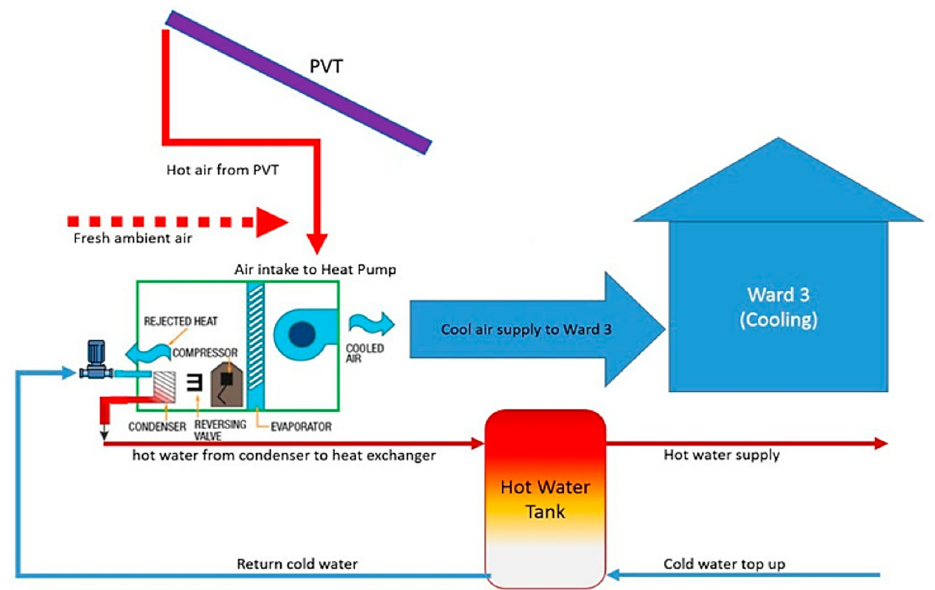
Figure 7. Hybrid system of PV/T and heat pump for naturally ventilation in building; reproduced from [159].